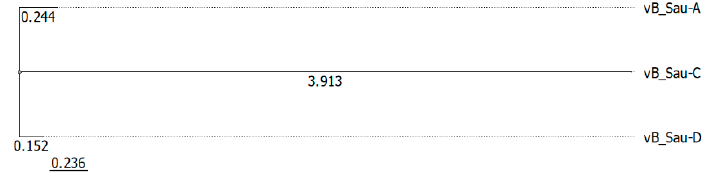
Figure 6. Phylogeny of newly isolated bacteriophages described in this Figure 5. Phylogeny of newly isolated bacteriophages described in this work.